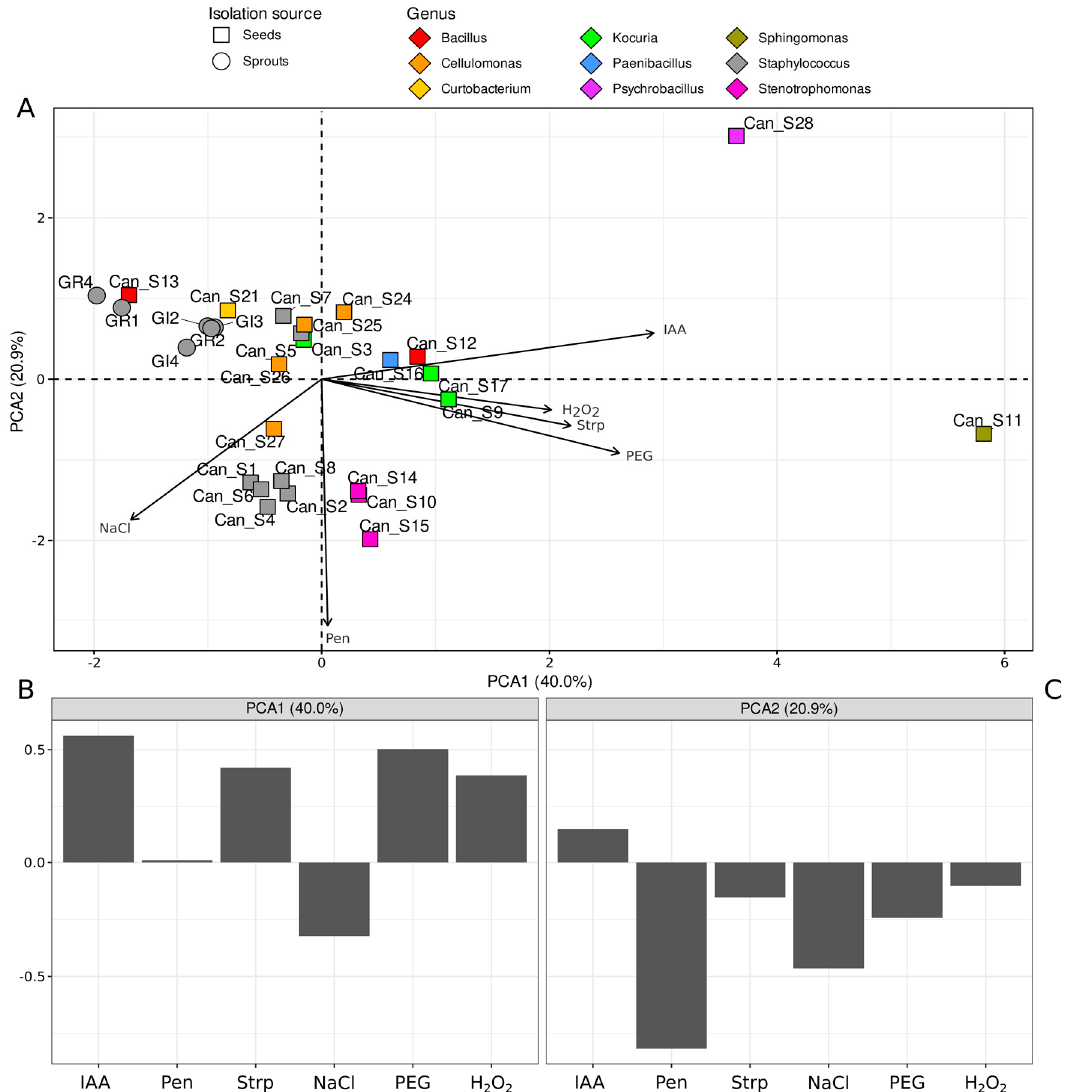
Figure 4. Principal component analysis representing the phenotypic characterization of bacterial strains. In this analysis, only variables from bacterial stress resistance and IAA production assays were considered. ( A ) Biplot of the ordination; the first (PC1) and second (PC2) principal components of the ordination analysis are reported. Each point represents an isolate, colored on the basis of its genus; circles represent isolates from sprouts, while squares represent isolates from seeds. Vectors point in the direction of highest variation of the variables and represent the contribution of each variable to a specific principal component (the greater the overlap with an axis, the greater the importance). ( B , C ) Importance of the different variables (e.g., variable loadings) on the first ( B ) and second ( C ) principal components.